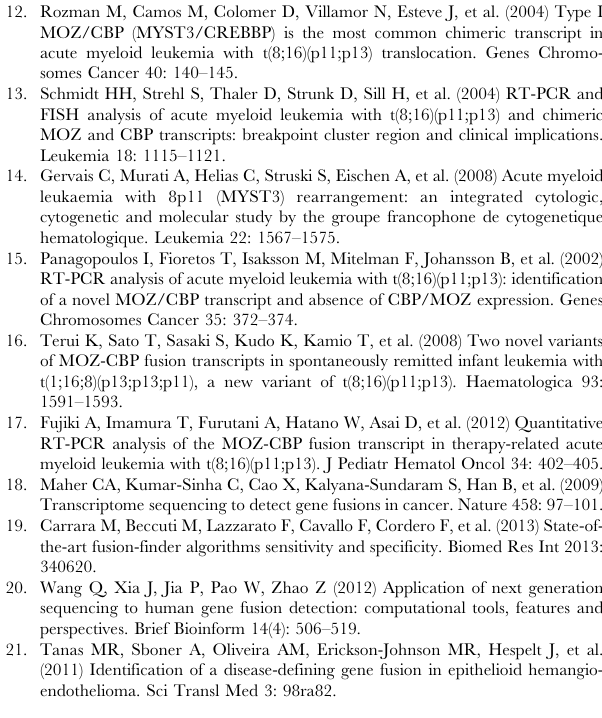
Table S1 Identified fusion genes using FusionMap on the raw sequencing data. Table S2 Identified fusion genes using